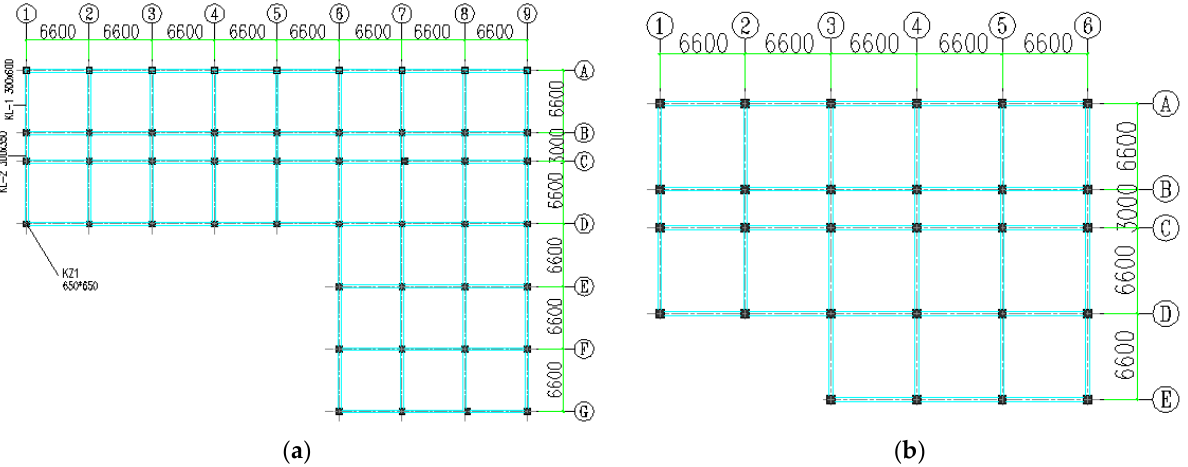
Figure 1. Typical floor plans of the ten-story L-shaped structure model. ( a ) 1st–6th floor ( b ) 7th–10th floor.